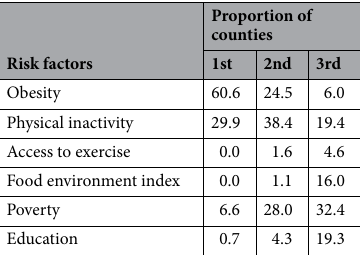
Table 3. The proportion of counties with local risk factors (the risk factor with the 1st, 2nd, and 3rd highest value of local variable importance) on the county-level T2D prevalence.